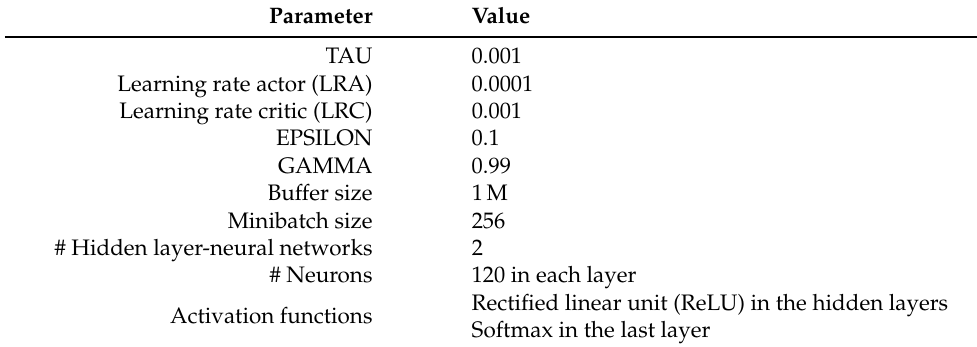
Table 1. Hyperparameters of the employed RL method used in this work.